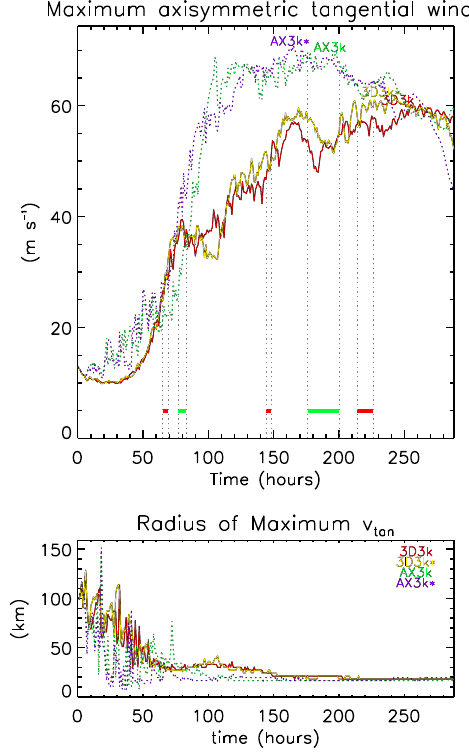
Fig. 1. Maximum azimuthally averaged tangential velocity ( V max ; top) and corresponding radius of maximum tangential wind (RMW; bottom) as a function of time for the four numerical experiments using the CM1 model as described in Sect. 2: the 3D3k simulation (solid red), the 3D3k ∗ simulation (solid yellow), the AX3k simulation (green dotted), and the AX3k ∗ simulation (purple dotted). In the top panel, the red and green bars bounded by gray, dashed lines denote intervals used in quantitative diagnostic analyses of mean and eddy dynamics presented in Sects. 4 and 6 for the 3D3k and AX3k simulations, respectively: 67h, centre of first rapid intensification period in the 3D3k simulation; 81h, centre of rapid intensification period in the AX3k simulation; 153 h, centre of second rapid intensification episode in the 3D3k simulation; 188 h, centre of mature period in the AX3k simulation; and 221 h, centre of mature period in the 3D3k simulation.